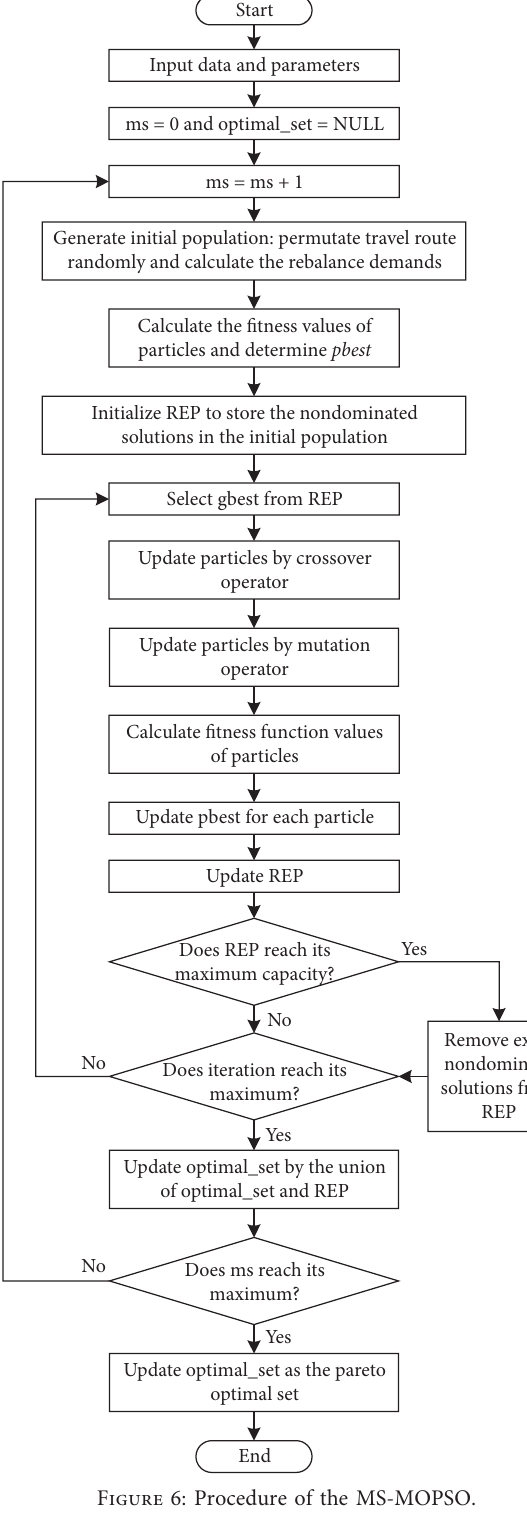
Figure 6: Procedure of the